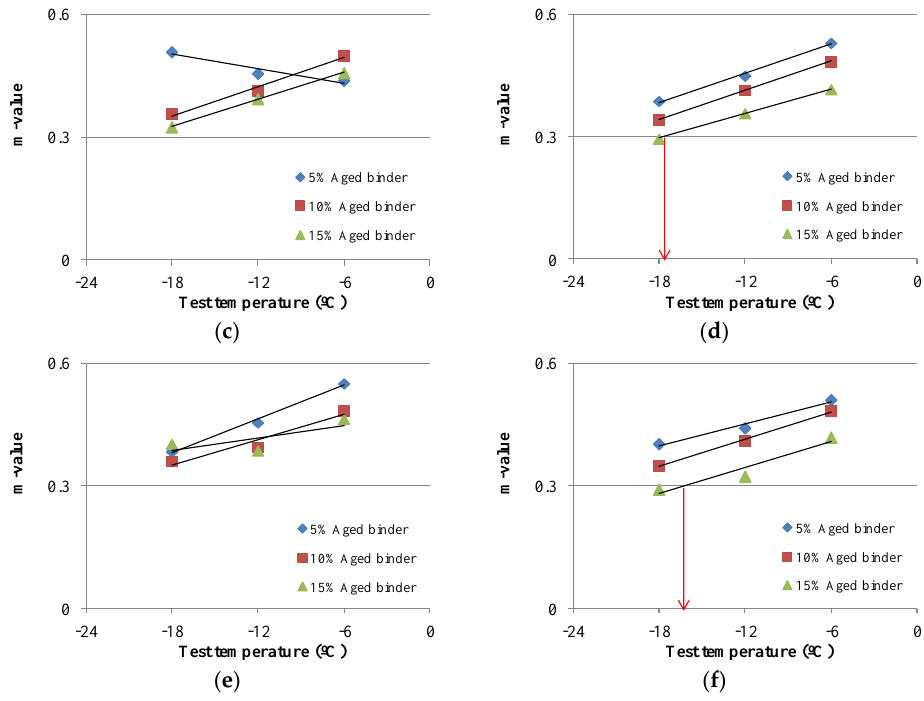
Figure 9. Minimum low temperature determinations of RAP sources A–F with PAV binder PG 58-28 in terms of m-value, ( a – f ) RAP sources A–F. Table 4. Minimum low temperatures of RAP sources A–F containing PAV binder PG 58-28. Min.